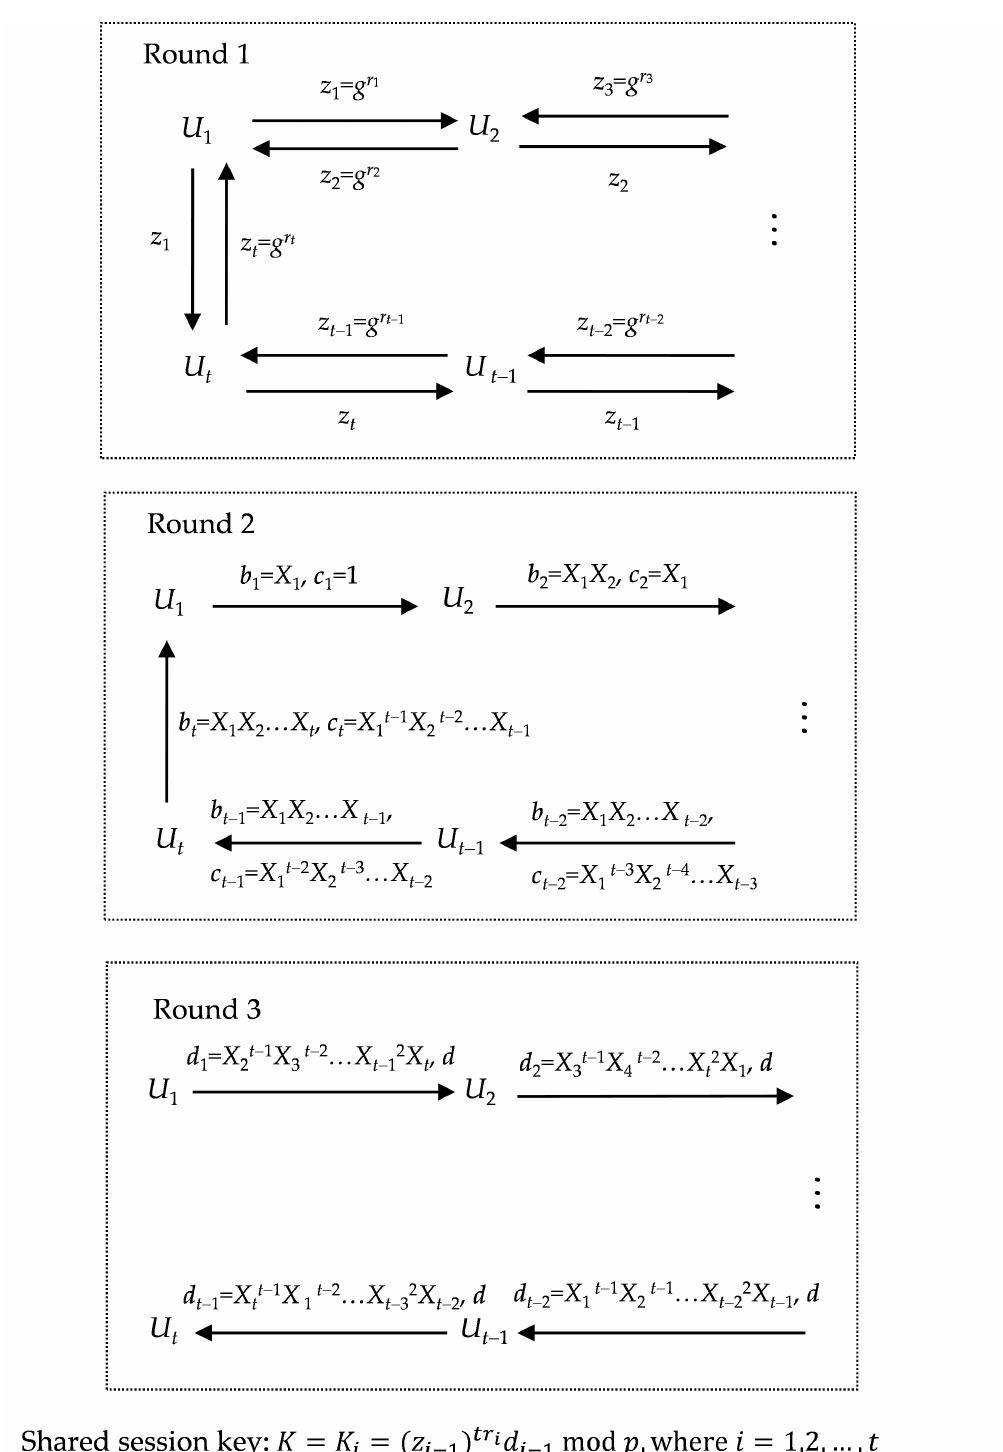
Figure 2. Communication and computation of cyclic